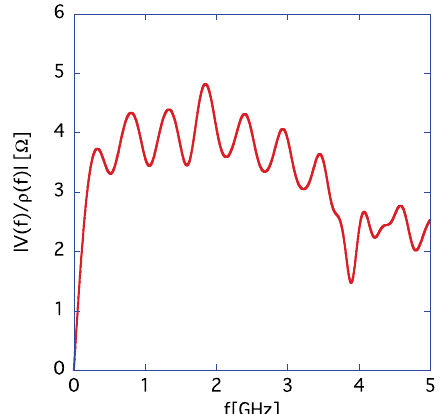
FIG. 4. The simulation result for the Linnercar ’ s exponential